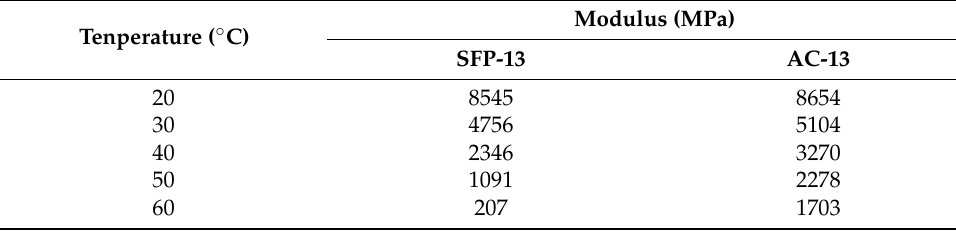
Table 1. The modulus of SFP and AC materials.